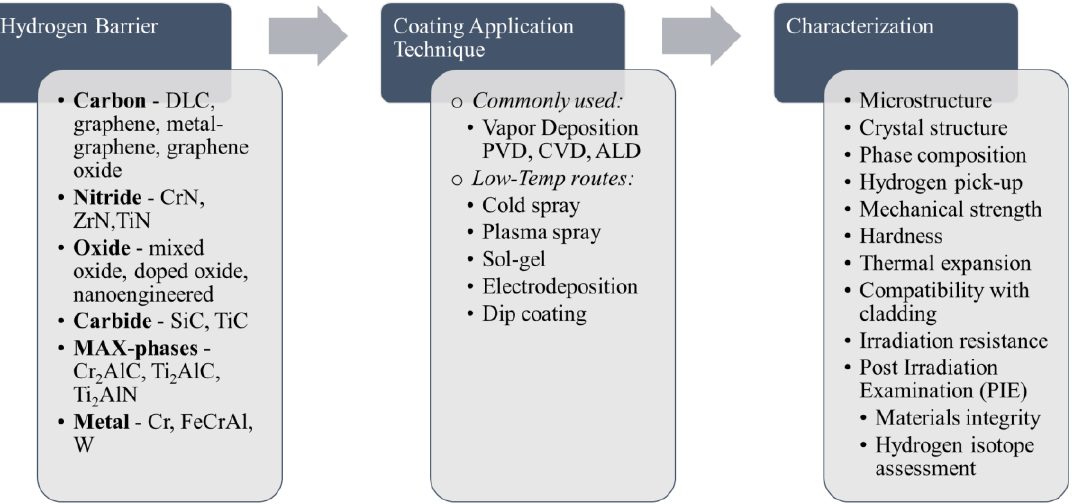
Figure 3. Summary of Advanced Hydrogen Barriers, Application Techniques and Characterization.